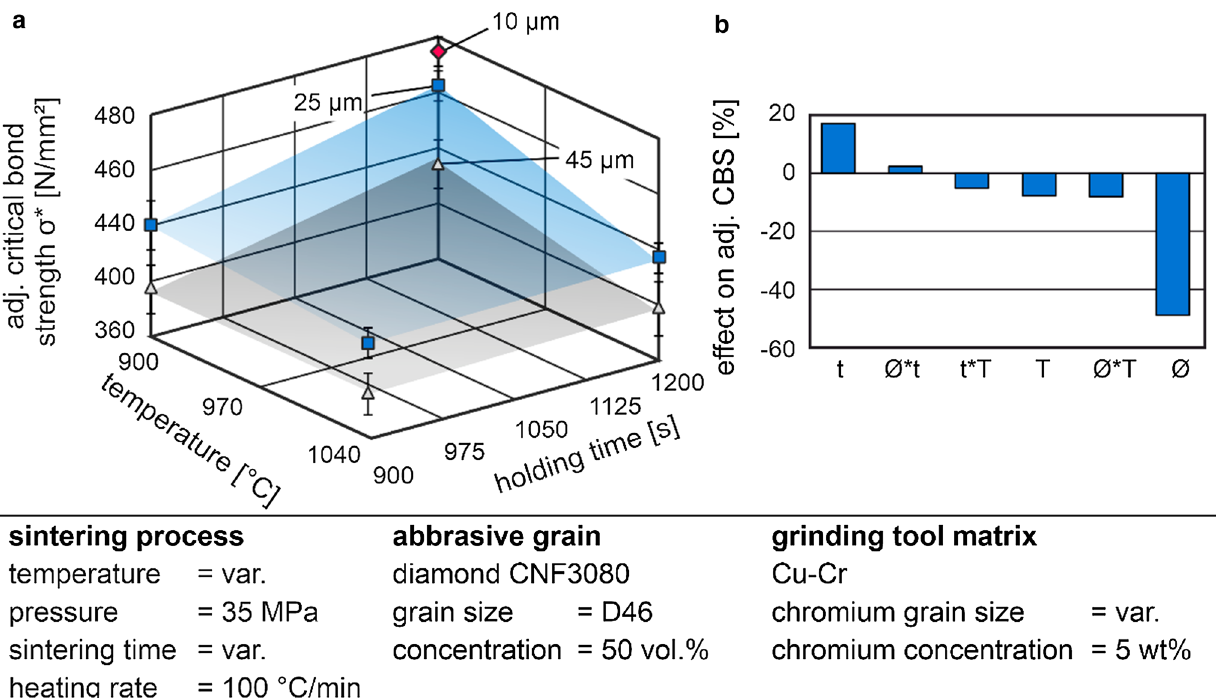
gle factors of temperature, holding time, and particle size as well as combined factors of